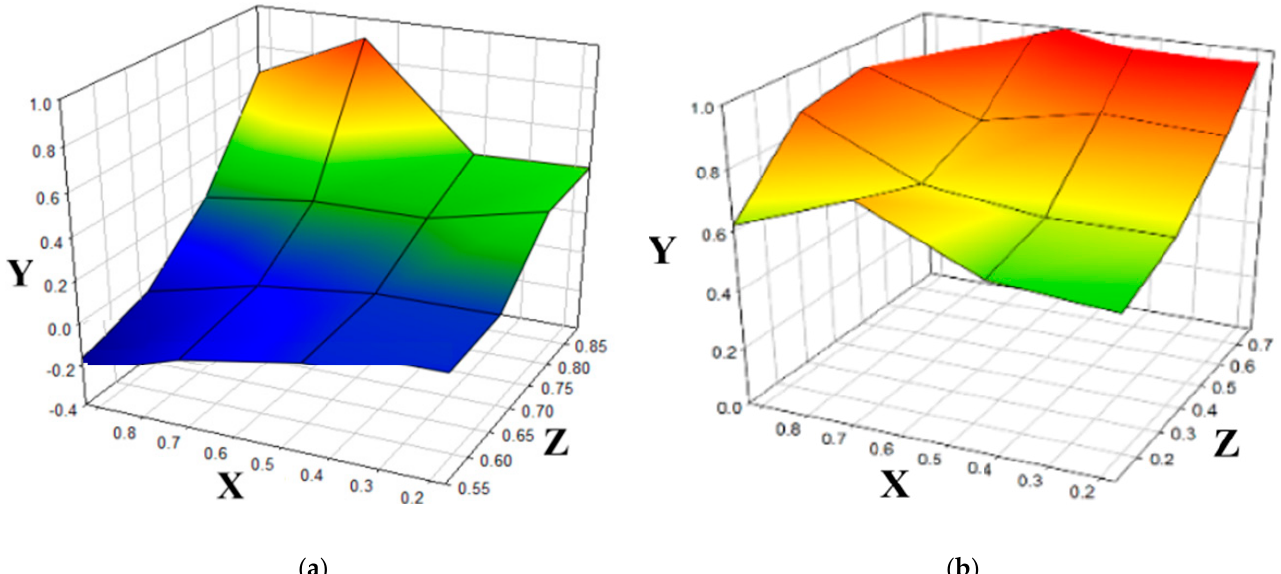
Figure 12. ( a ) Illustration of a higher diffusion for entire fitness functions, which demonstrates extreme overfitting; ( b ) shows perfect performance of the LT optimum fitness.